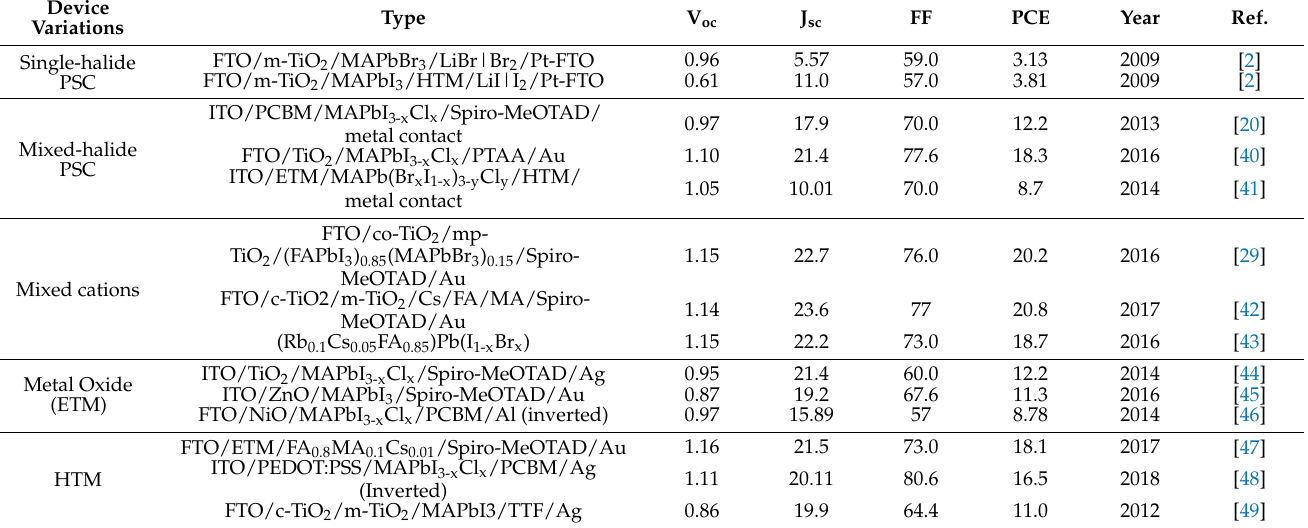
Table 1. Types of PSCs with device architecture “TCO/ETM/Perovskite layer/HTM/metal contact” varied by the perovskite layer, ETM and HTM